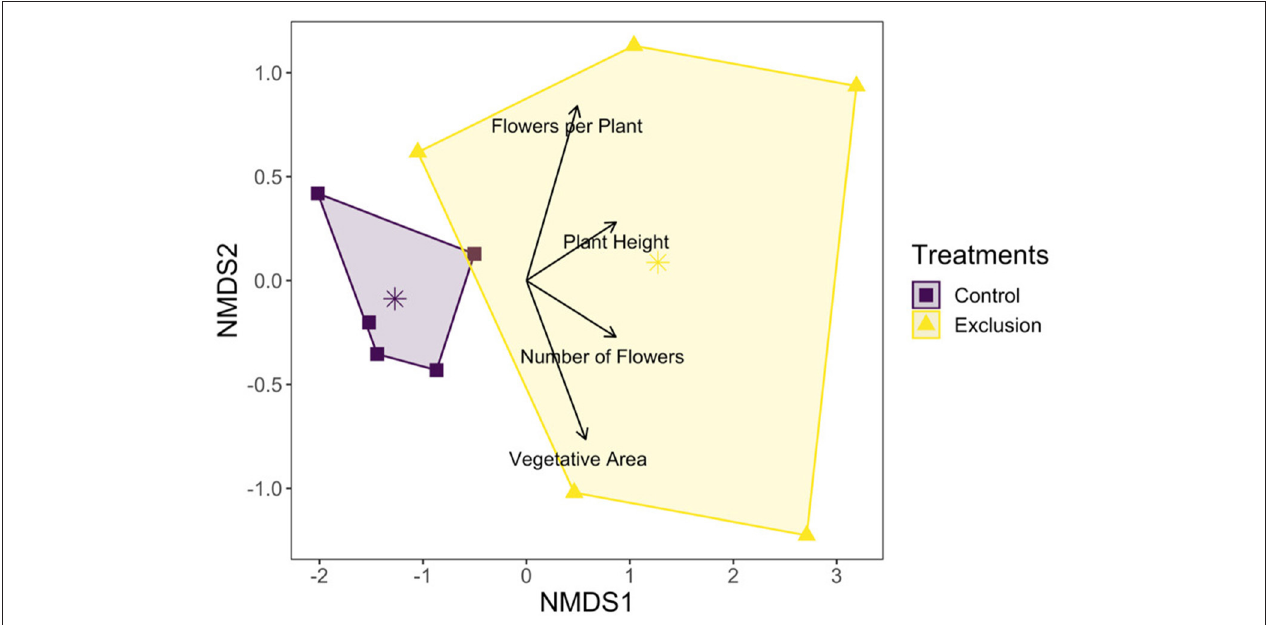
FIGURE 2 | NMDS plot showing net vegetation response based on community weighted means of plant response variables to deer presence and absence. Points represent net average community response values for each control and exclusion plot, and arrow length reflects the relative contribution of each plant response variable to the magnitude of community response. The larger area for the exclusion treatment polygon reflects greater overall variability in plant response values compared to the control treatment.